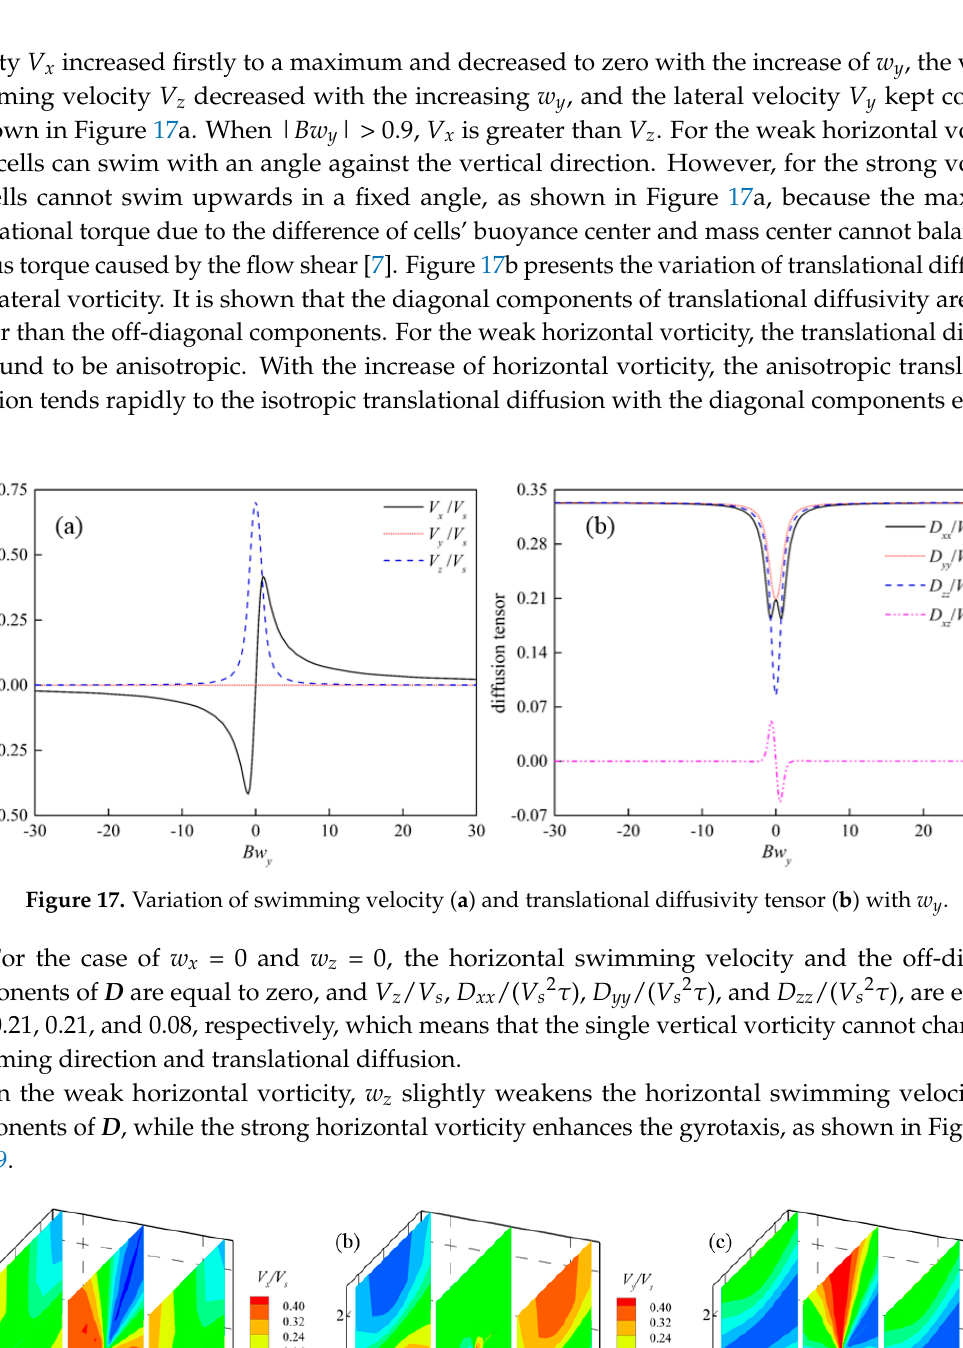
Figure 19. Translational diffusion tensor, ( a ) D xx / V s2 τ , ( b ) D yy / V s2 τ , ( c ) D zz / V s2 τ , ( d ) D xy / V s2 τ , ( e ) D xz / V s2 τ , and ( f ) D yz / V s2 τ with w x , w y , and w z . 4. Discussion Some swimming patterns of gyrotactic micro-organisms found in previous studies [11,12,49,50] have also been observed in this work, such as helical trajectories, straight trajectories, and the combination of helical and straight trajectories, as shown in Figure 3d. In the present work, the Equation (3) for computing three-dimensional velocity of cells was based on the assumption that the swimming velocity of cells in x - and y -directions is isotropic, which has been testified by previous studies for gyrotactic micro-organisms [17]. The swimming velocity of H. akashiwo , to some extents, depends on external environments and its strains, as shown in Table 2. Harvey and Menden-Deuer [12] found that the swimming speed of H. akashiwo increased by 38% in the presence of a predator, while Strom et al. [23] found that the presence of a predator resulted in an increase of 22% and a decrease of 58% of swimming speed below